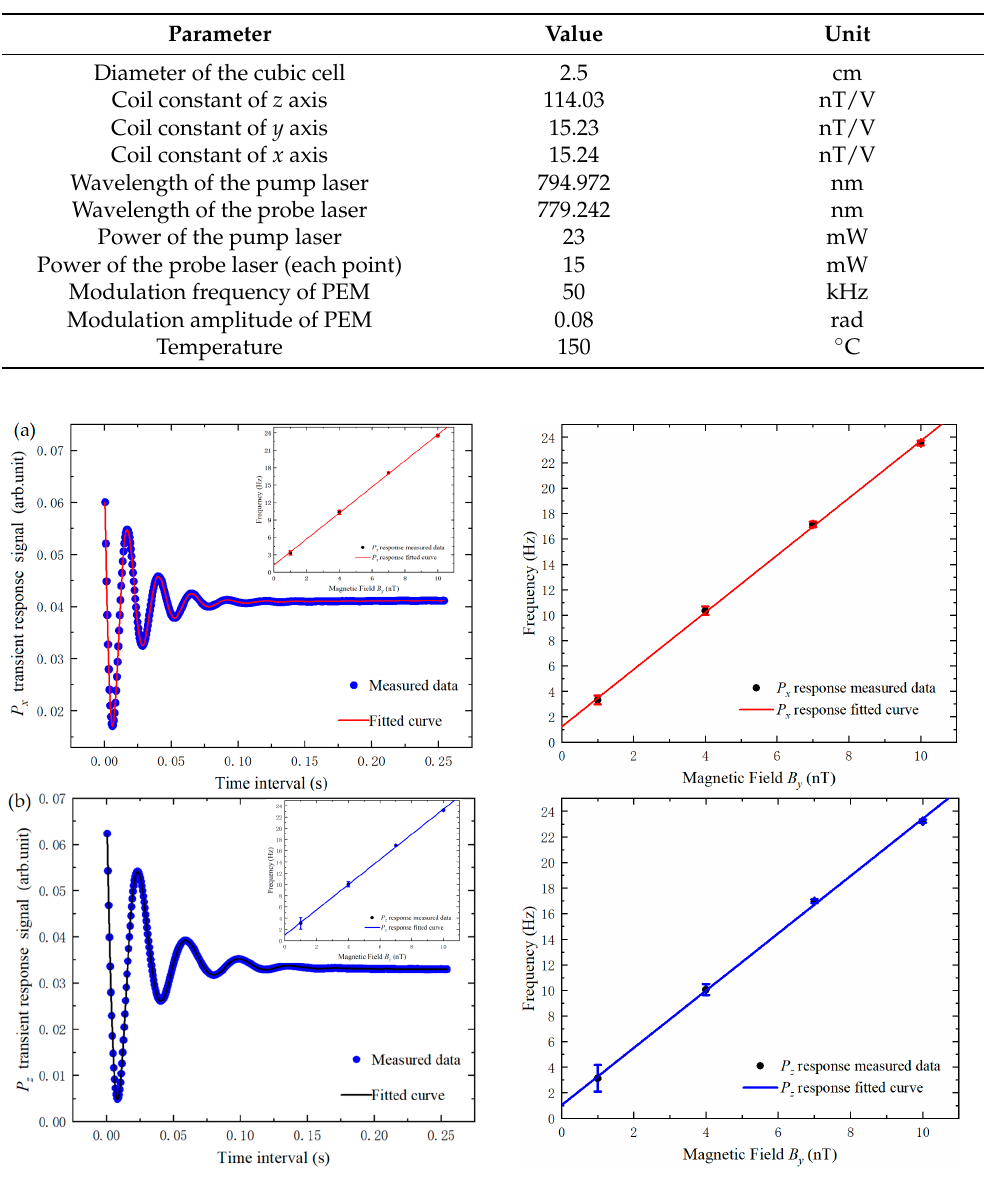
Figure 4. Experimental measurement data of the magnetometer transient response at B y = 7 nT. The dots are the measured data, and the solid line is the curve fitted to Equation (10). The inset measures the variation in ω with B y , and the measurement results in a linear relationship between ω and B y . The intercept is the residual magnetic field inside the magnetometer. ( a ) Probe light path A in Figure 2 ( P x transient response). ( b ) Probe light path B in Figure 2 ( P z transient response). An expanded version of the inset is at the right of the image.